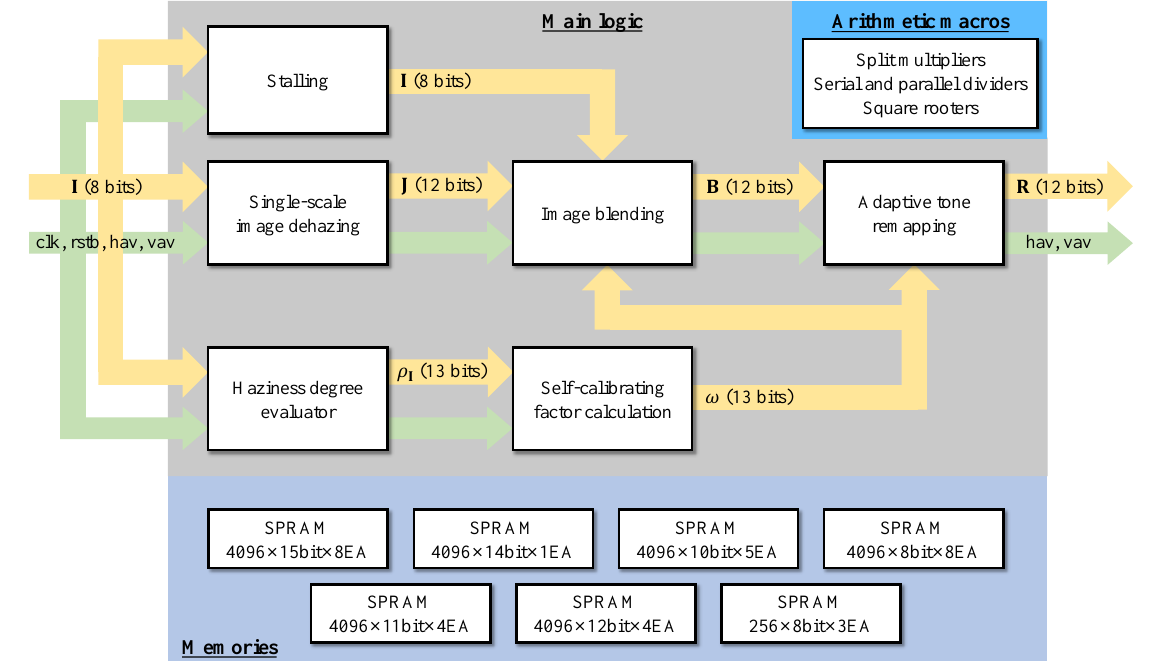
Figure 6. Pipelined architecture of the proposed FPGA